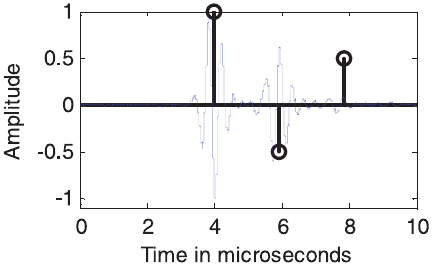
Fig. 6. Waveform in undamaged region and deconvolution result.